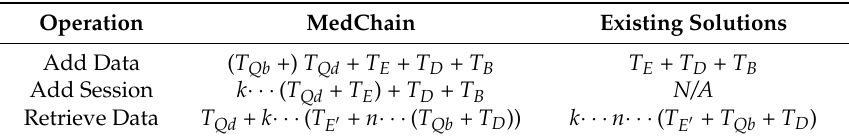
Table 2. Communication overhead comparison.